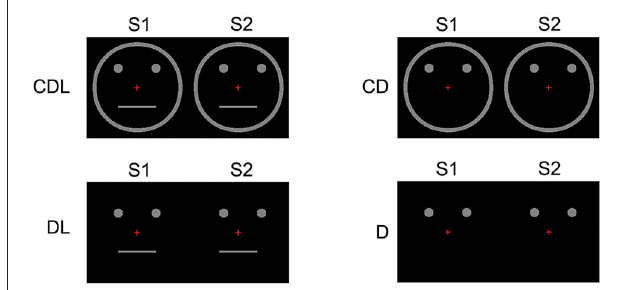
FIGURE 3 | Examples of the stimulus conditions. (1) CDL: schematic face consisting of a Contour, two Dots, and a horizontal Line, (2) CD: the Contour and two Dots, (3) DL: two Dots and a horizontal Line, and (4) D: two Dots only (adopted from Miki et al., 2007).